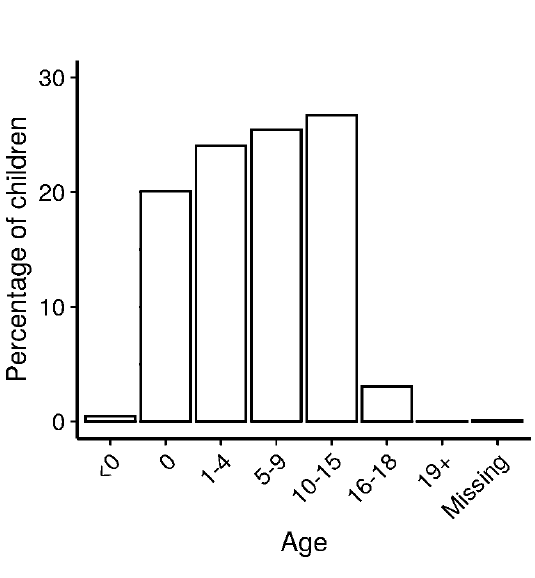
Figure 4: Children’s ages and family compositions in public family law proceedings starting in 2017/18. (a) Child age at the start of proceedings